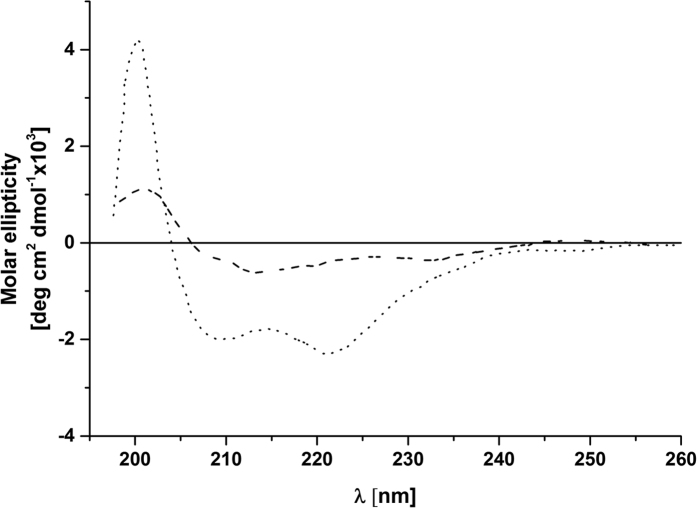
Circular dichroism spectroscopy of PsbW in aqueous buffer (unfolded) and DDM micelles (refolded).Spectra are shown for the protein in aqueous buffer (dashed line) and after incorporation into DDM micelles (dotted line).